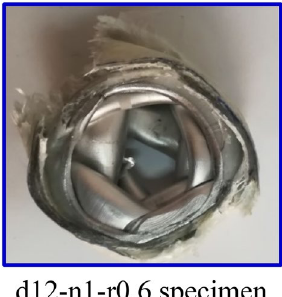
Figure 8. Top view of the representative sample of crushed